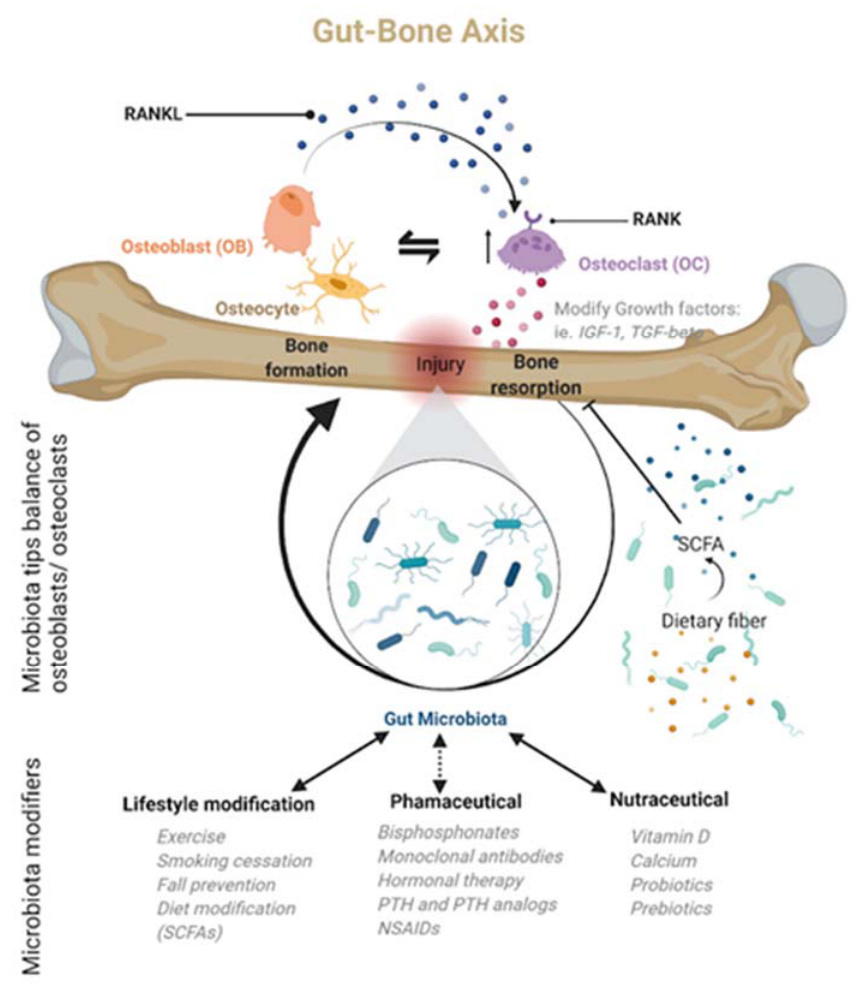
Figure 2. The gut microbiota is only now being recognized as a central regulator of bone homeostasis, particularly after an injury, in what is now being called the gut–bone axis. Many of the regulatory actions are mediated by the microbiota’s metabolic products. Based on this newly recognized microbiota role, bone homeostasis or dysbiosis may be modulated by lifestyle changes, nutraceuticals, or pharmacological agents. Created with BioRender.com.